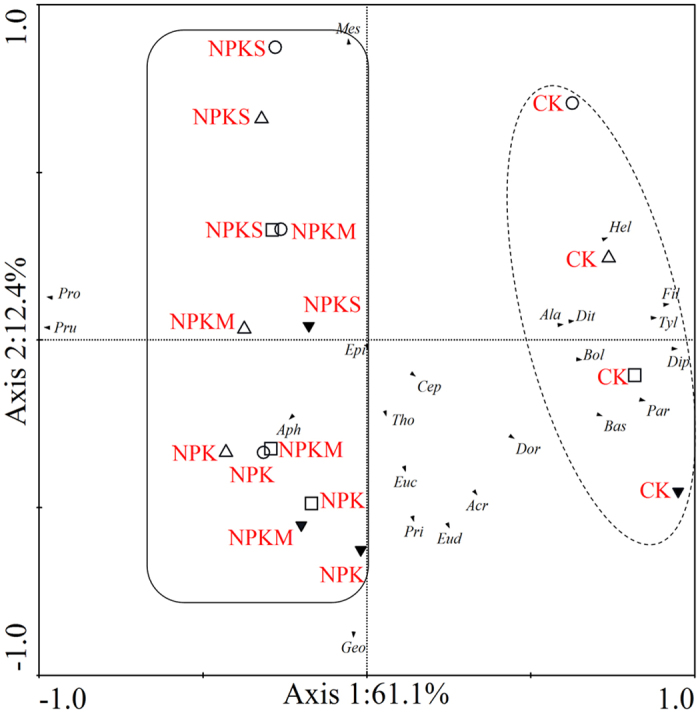
Principle component analysis of nematode genera composition within various aggregate fractions under different fertilization treatments.▾, ◻, ∆, ⚪ represent >2 mm, 1–2 mm, 0.25–1 mm and <0.25 mm, respectively. Mesorhabditis, Mes; Cephalobus, Cep; Eucephalobus, Euc; Acrobeloides, Acr; Prismatolaimus, Pri; Alaimus, Ala; Filenchus, Fil; Ditylenchus, Dit; Paraphelenchus, Par; Aphelenchoides, Aph; Diphtherophora, Dip; Tylencholaimus, Tyl; Thonus, Tho; Eudorylaimus, Eud; Epidorylaimus, Epi; Dorydorella, Dor; Boleodorus, Bol; Basiria, Bas; Geocenamus, Geo; Helicotylenchus, Hel; Pratylenchus, Pru; Pratylenchoides, Pro.